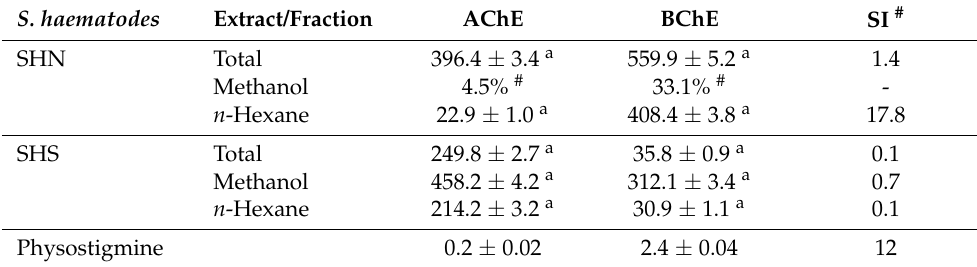
Table 1. Cholinesterases (AChE and BChE) inhibitory activity (IC 50 µ g/mL) of S. haematodes . S. haematodes Extract/Fraction AChE BChE SI # SHN Total 396.4 ± 3.4 a 559.9 ± 5.2 a 1.4 Methanol 4.5% # 33.1% # - n -Hexane 22.9 ± 1.0 a 408.4 ± 3.8 a 17.8 SHS Total 249.8 ± 2.7 a 35.8 ± 0.9 a Methanol 458.2 ± 4.2 a